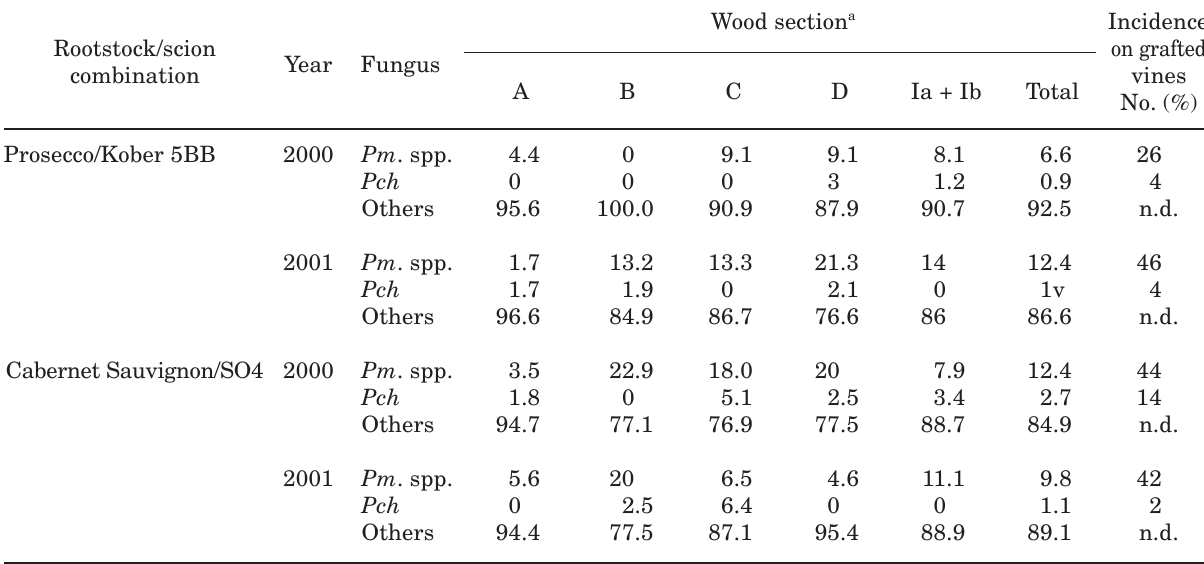
Table 2. Percentage of esca-associated ( Phaeoacremonium spp. , Pm. spp.; Phaeomoniella chlamydospora, Pch) and other fungi from wood segments taken from different positions on the rootstock and from the graft area of bench grafted rooted vines of two rootstock and scion combinations, and incidence of colonized vines in 2000 and